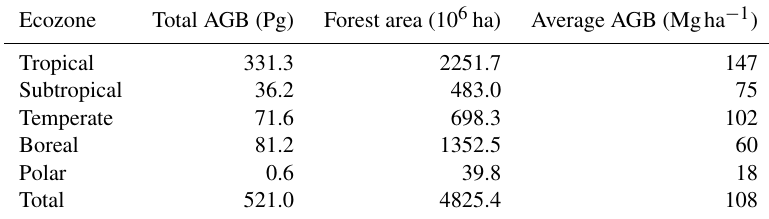
Table 1. Total AGB, forest area, and average AGB per major